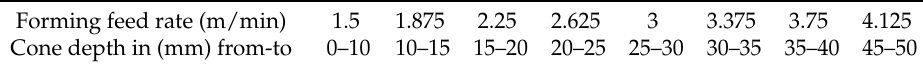
Table 1. The feed rate as a function of cone depth during forming.